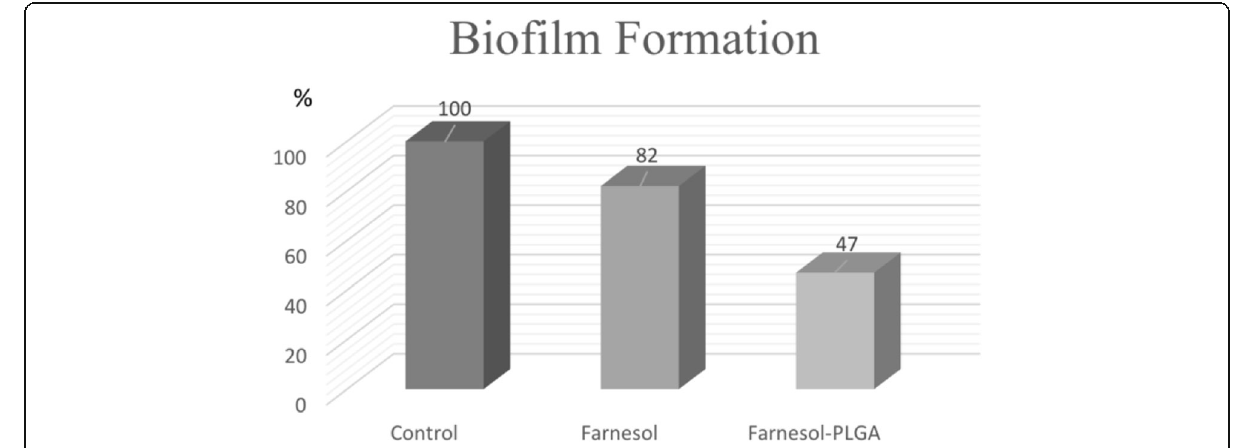
Fig. 6 Demonstration of biofilm formation according to XTT test